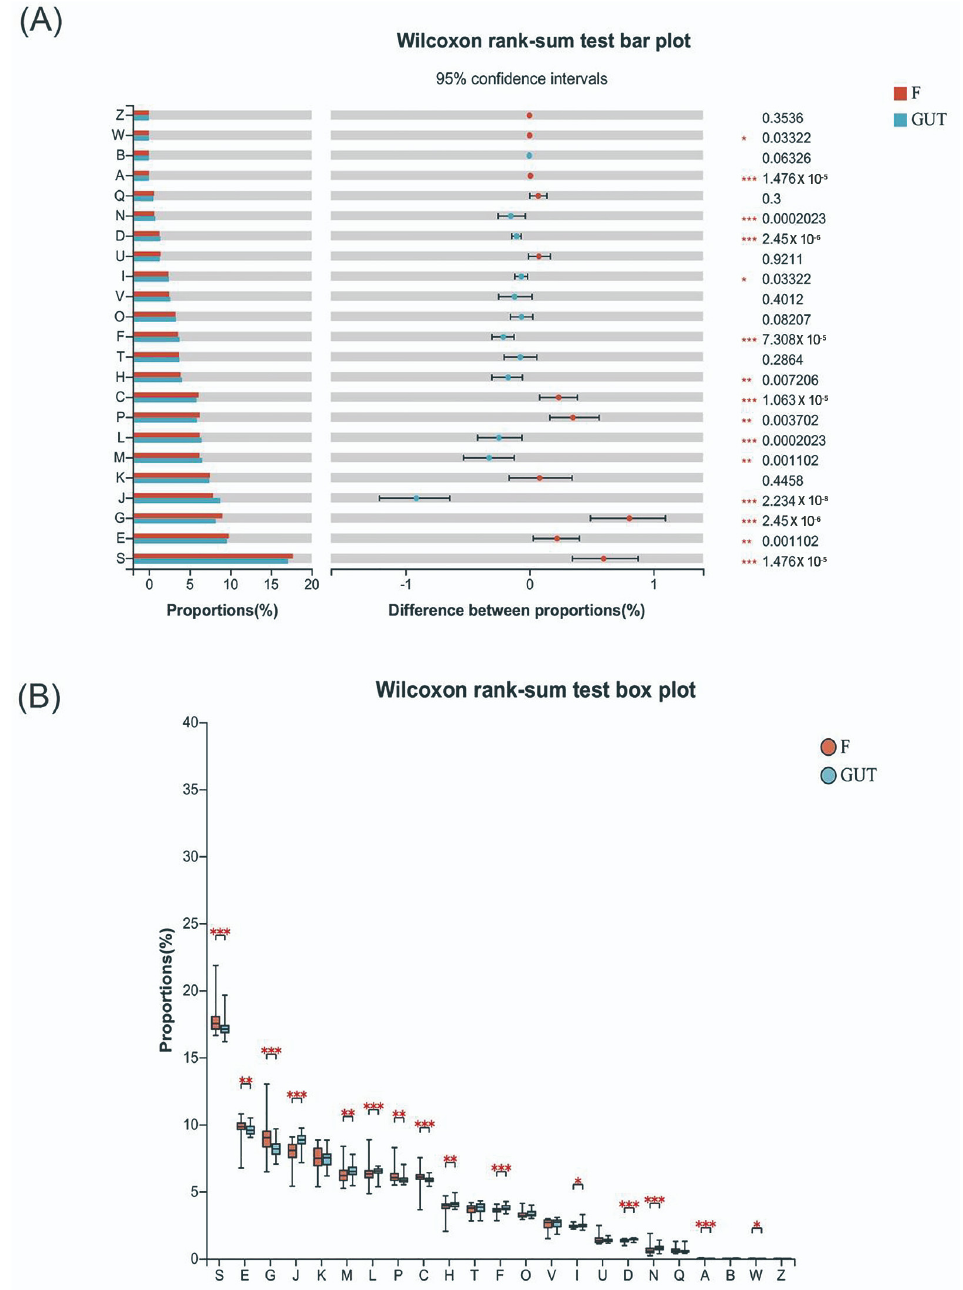
Figure 5. Tryptophan–kynurenine pathway items may be potential biomarkers of MDD. ( A ) KEGG orthologous analysis found significant differences in cell cycle control, cell division and chromosome partition, the transportation and metabolism of nucleotides, amino acids, carbohydrates, and inor- ganic ions, and energy production and conversion between MDD patients and the control group. ( B ) Indole amines, such as Trp, Ido, and Kyn, are key metabolic products related to MDD.